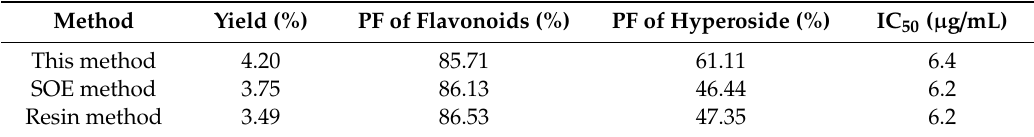
Table 3. Evaluation of the proposed separation